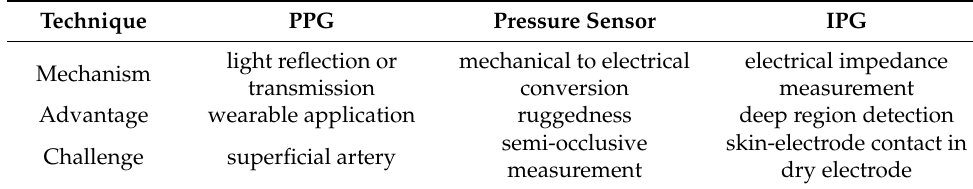
Table 1. Comparison for different pulse measurement